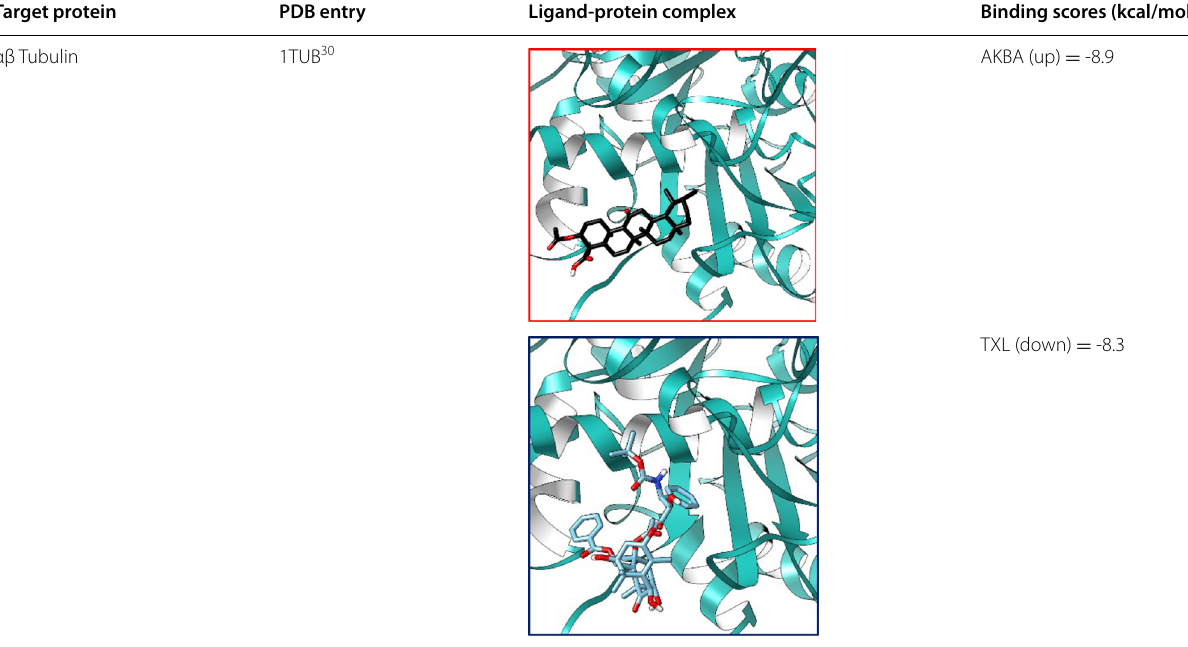
In the structural depictions, AKBA (black) and TXL (red) occupy the defined active site of the target protein which is employed in its crystallographic state as retrieved from the protein data